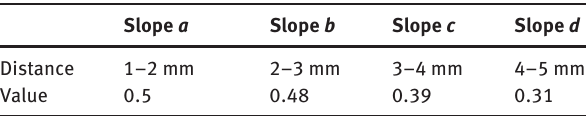
Table 2: The slopes values extracted for each two integers in the DR